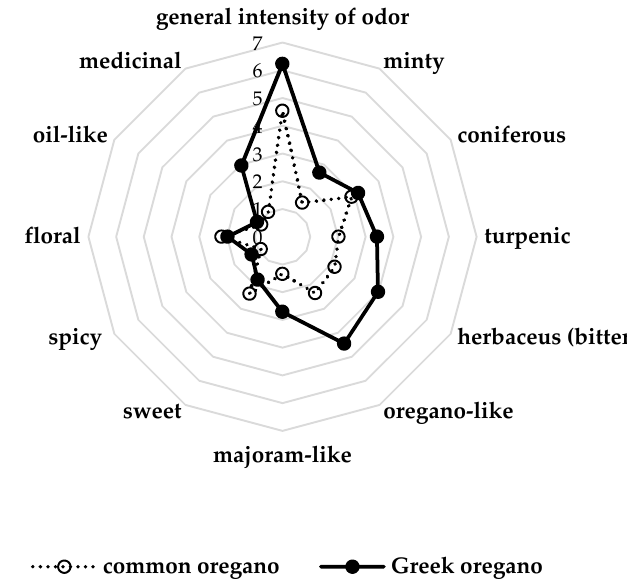
Figure 3. Sensory profile of herb odor of common oregano and Greek oregano.